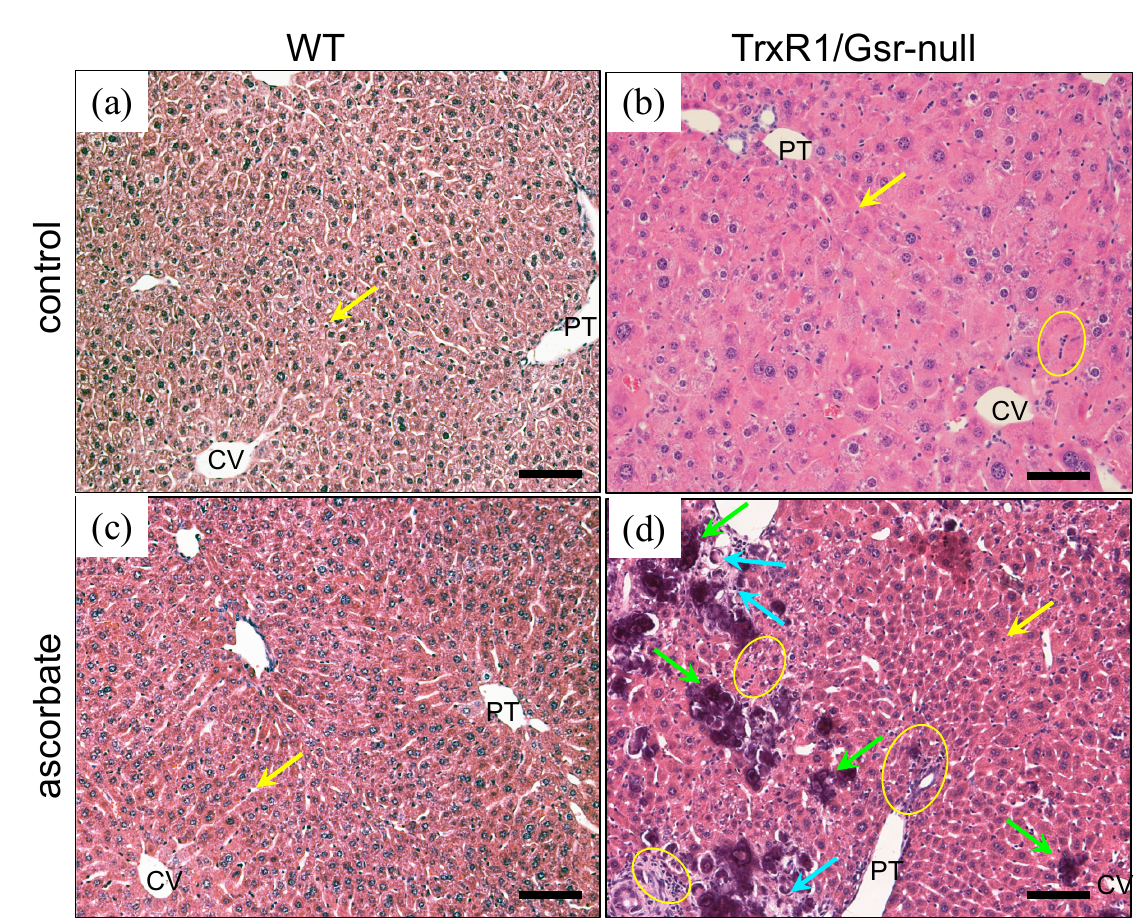
Figure 2. Histology of Gsr-null and TrxR1/Gsr-null livers treated with ascorbate. Mice with WT ( a , c ) or TrxR1/Gsr-null ( b , d ) livers received no treatment (control) or 4 daily i.p. injections of 4 mg/g ascorbate (ascorbate). Yellow arrows mark isolated sinusoidal leukocytes (small dark-staining cells) and yellow circles denote areas with larger groups of leukocytes. Green arrows denote intensely purple-staining Langhan-type giant macrophages, which tend to be focused in regions with increased necrotic hepatocytes (blue arrows). Representative images shown from n = 3–5 mice of each condition. CV and PT, representative central veins or portal triads, respectively. Scale bars, 100 μ m.